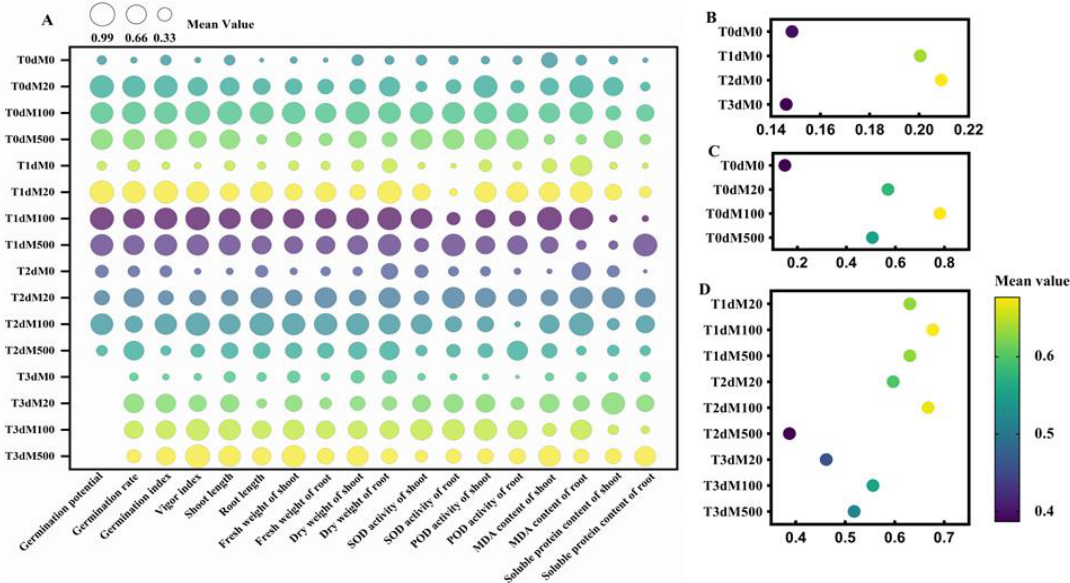
Figure 9. Comprehensive evaluation of melatonin and flooding stress on each index ( A ), the single-flooding stress ( B ), single-melatonin ( C ), and interactive treatments ( D ).